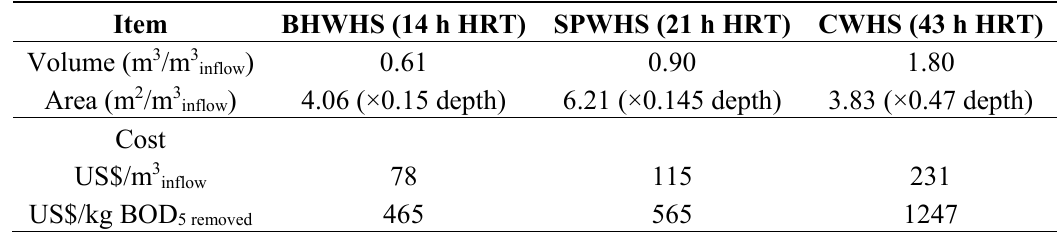
Table 5. Pre-estimated capital cost of the water hyacinth wetland system under